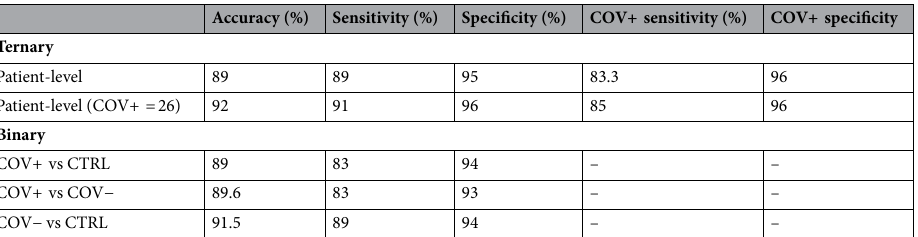
Table 4. (Ternary) CNN accuracy, sensitivity and specificity at the patient level of the ternary (COV+ vs COV− vs CTRL) classification model using leave-one patient out cross-validation, with the related COV+ sensitivity and specificity percentages. (Binary) CNNs accuracy, sensitivity and specificity at the patient level for the binary (COV+ vs CTRL, COV+ vs COV− and COV− vs CTRL) classification